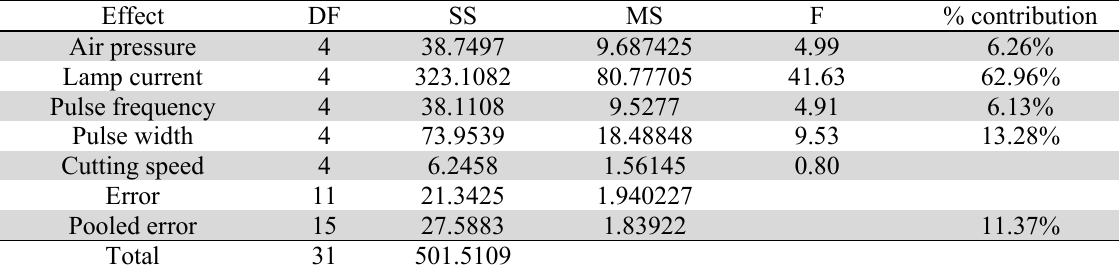
ANOVA results for deviation of